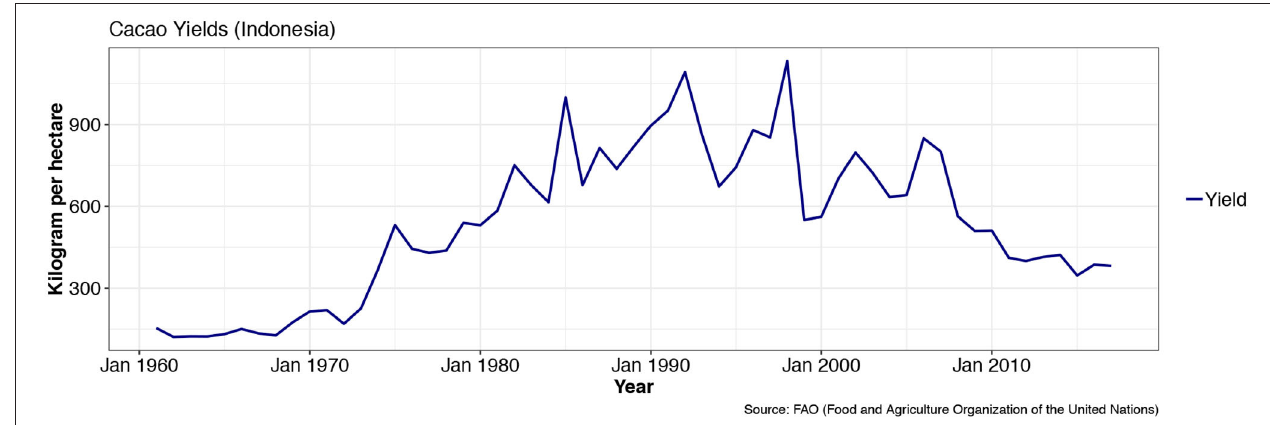
FIGURE 1 | Cacao Yield Trends, Indonesia, 1961–2017. This graph was compiled using cacao yield data from FAOSTAT (http://www.fao.org/faostat/en/#data). Data available through FAOSTAT are country-reported and represent a nation-wide average yield value. Thus, they are subject to distortion and may mask important variation between regions and